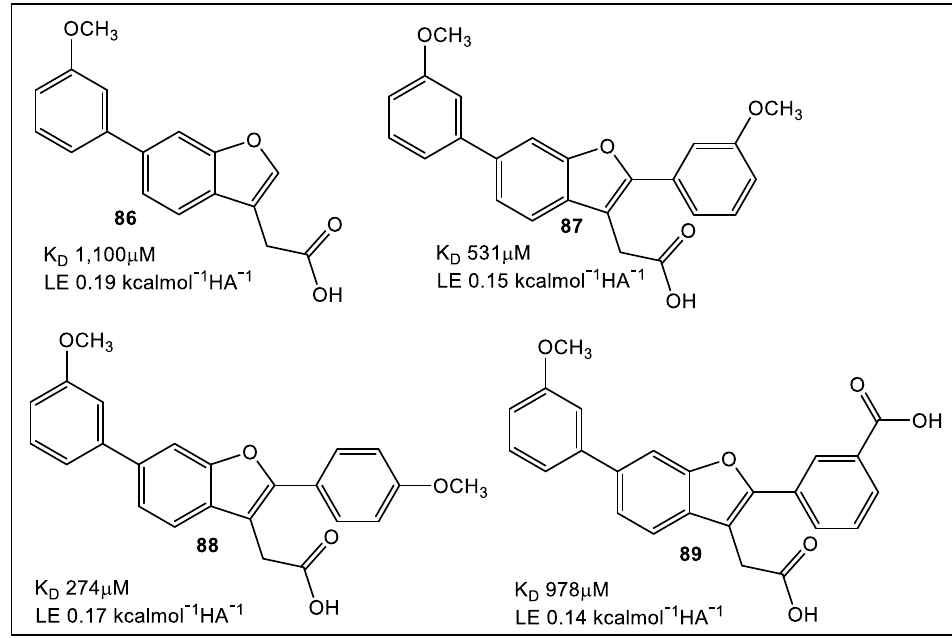
Figure 15. Fragment 86 was identified by NMR and X-ray crystallography as an initial analog for scaffold building. The synthesis started from C-2 to access a more polar region of the binding groove. Confirmation of the appropriateness of C-2 as a starting area for binding pocket access was validated by crystal structural analysis of 87 , 88 , and 89. Subsequent studies using HSQC showed that relative to parent compounds, C-2 analogues exhibited enhanced K D values. In addition, C-2 analogues inhibited DsbA. This also indicates that there is the potential for development of benzofuran analogues, which could target virulence [73].